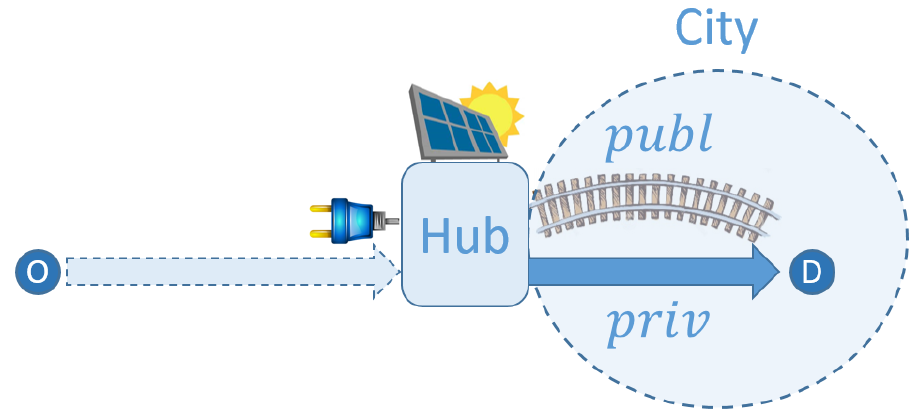
Figure 1. Schematic representation of the charging hub scenario: commuters can either choose to leave their vehicle at the hub and take public transport ( publ ), or drive all the way to their destination ( priv ). A local source of renewable energy is available at the